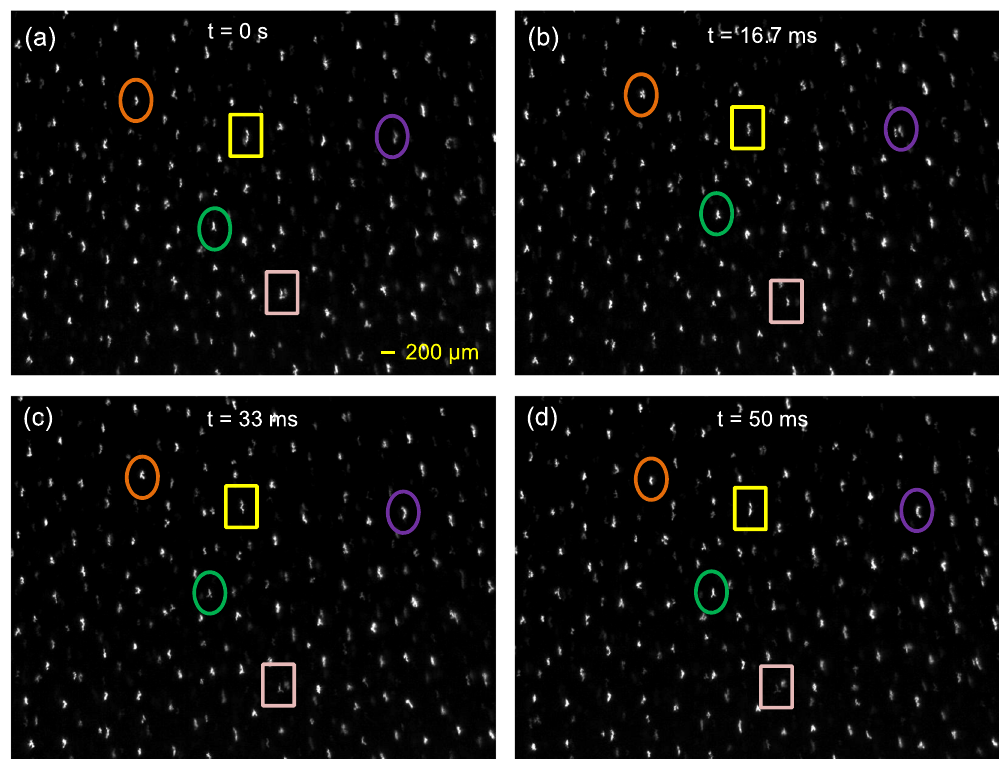
Figure 4. Rotation of nonspherical water-ice particles about their alignment axis in a plasma. ( a – d ) Sequential images showing that ice particles rotate about their alignment axis. The time step between images is 1/60 s. It is clearly seen that most particles rotate about their alignment axis and the rotation frequency ranges between 20 and 50 Hz. The rotation results from the interaction between the horizontal intrinsic dipole moment and the horizontal electric field inside plasma 19